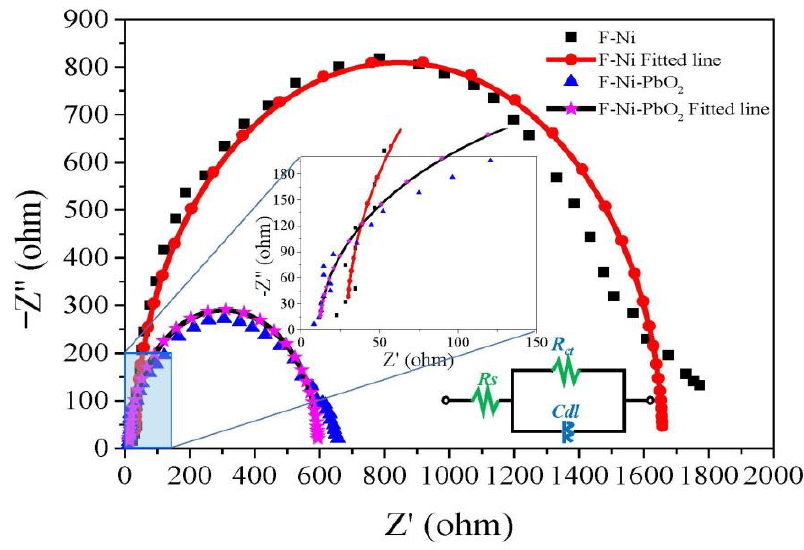
Figure 3. Experimental and simulated Nyquist plots of nickel foam and PbO 2 -FN electrodes.